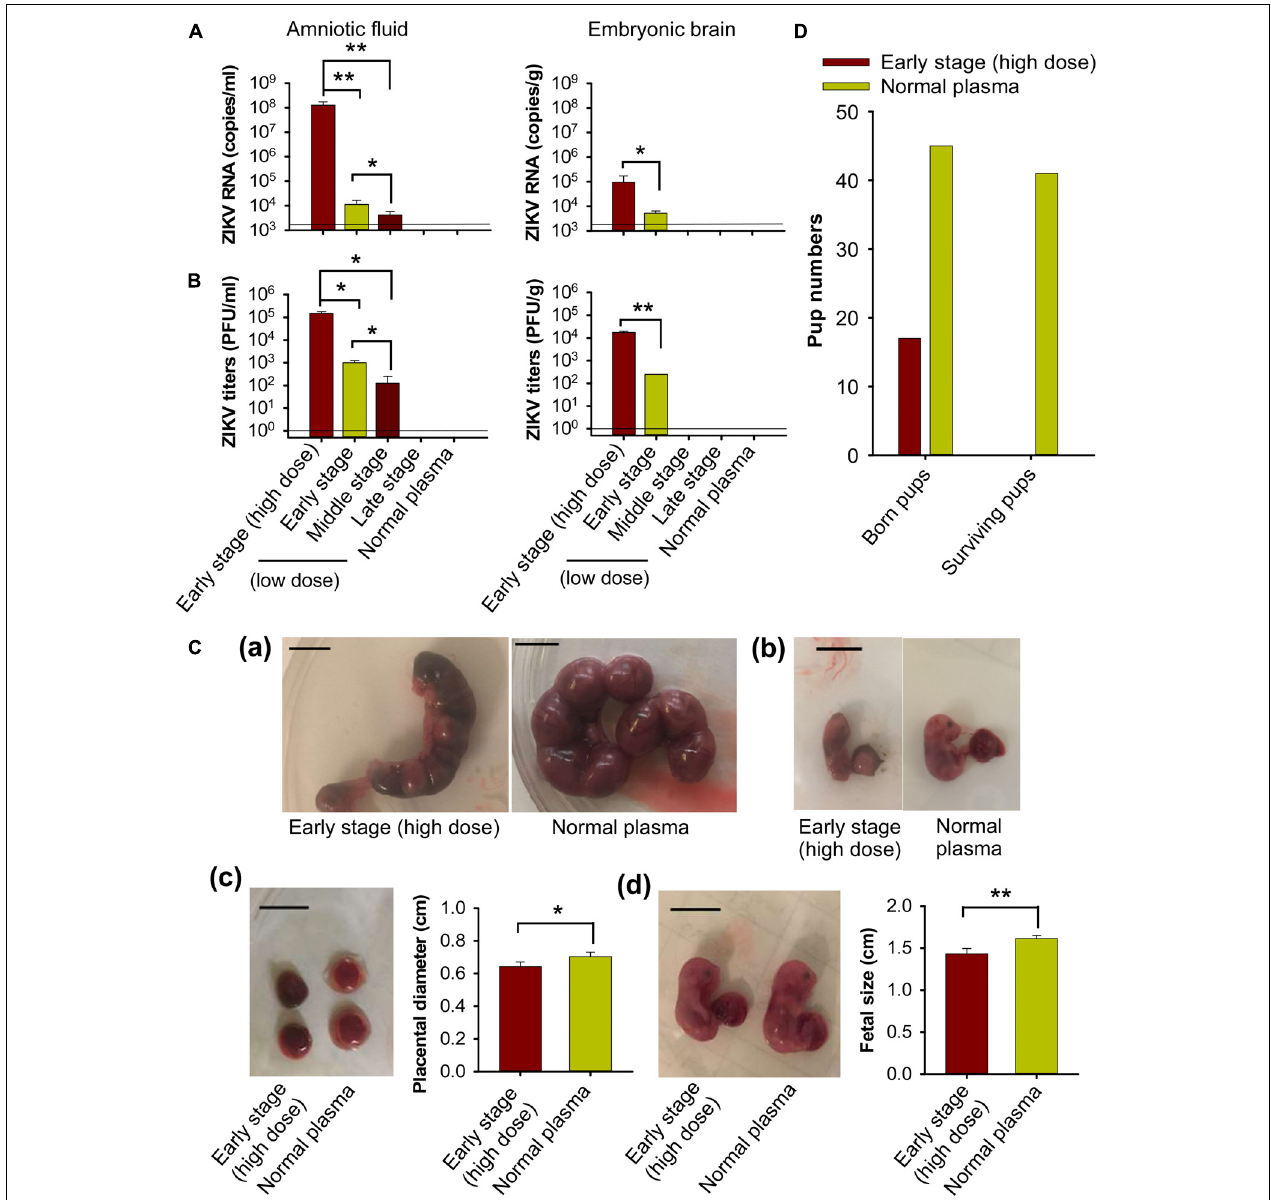
FIGURE 6 | Transfusion of pregnant A129 mice with early-stage (high dose) ZIKV + plasma led to significant fetal infection and fetal and pup death. Pregnant (E10–12) A129 mice were transfused with ZIKV + plasma from early, middle, and late stages, respectively. ZIKV RNA and ZIKV titers were detected by qRT-PCR (A) and plaque assay (B) in amniotic fluid and embryonic brain collected 6 days post-transfusion. The detection limit, shown as the horizontal lines, was about 2.5 × 10 3 RNA copies/ml and 1 PFU/ml (for amniotic fluid), or 2.5 × 10 3 RNA copies/g and 1 PFU/g (for embryonic brain), respectively, for qRT-PCR and plaque assay. ∗ and ∗∗ indicate significant differences between early stage (high dose) and early or middle stages (low dose), or between early and middle stages (low dose). The data are presented as means ± s.e.m ( n = 6 mice/group). (C) Morphology of mouse uteri and placentas and conditions of fetuses 6 days after transfusion of early-stage (high dose) ZIKV + plasma. (a) E13–15 uteri from pregnant mice transfused at E7–9. (b) Representative images of fetuses in (a) . (c) E16–18 placentas from pregnant mice transfused at E10–12. (d) Representative images of E16–18 fetuses in (c) . Scale bar: 1 cm. Placental diameter in (c) and fetal size in (d) are shown. ∗ and ∗∗ indicate significant differences between early stage (high dose) and normal plasma groups. The data are presented as means ± s.e.m ( n = 6 mice/group). (D) Total born and surviving pups 24 h after birth from pregnant (E10–12) mice transfused with early-stage (high dose) ZIKV + plasma. Normal plasma: control plasma from A129 mice transfused with normal plasma without